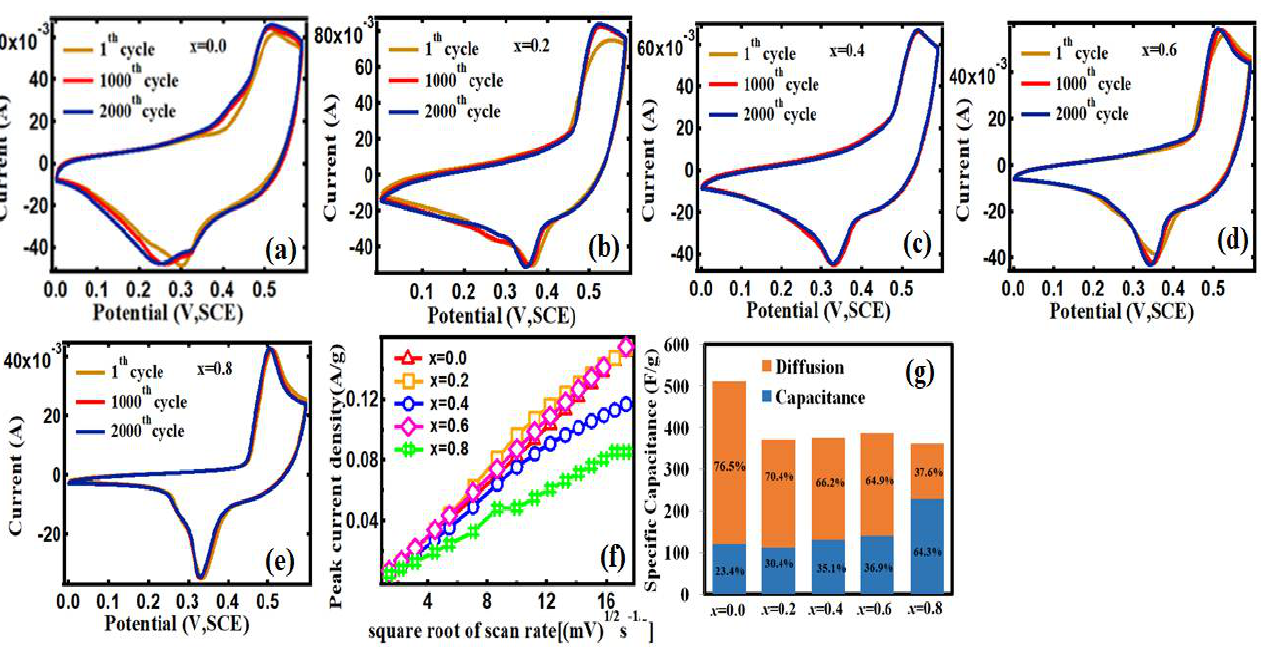
Figure 5. ( a – e ) are cyclic stability curves of Ni 1-x Al x Co 2 O 4 measured up to 2000 cycles in 3M KOH electrolyte, ( f ) peak current vs. (scan rate) 1/2 , and ( g ) diffusion and capacitive contribution to the specific capacitance.